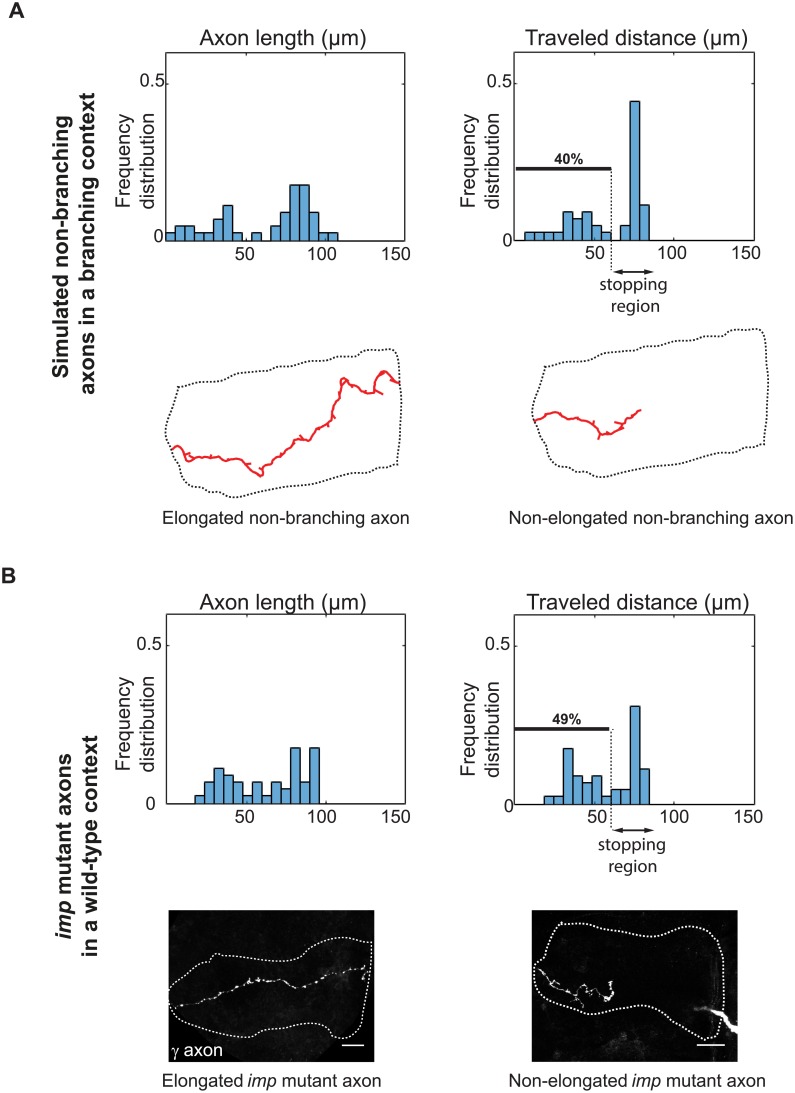
Out-competition of non-branching axons by branching ones.(A) Top: frequency distributions of 2D-projected axon lengths and traveled distances of single simulated non-branching axons grown in the context of otherwise branching axons. 40% of axons fail to reach the lobe extremity in this condition (n = 45). Bottom: examples of fully elongated (left) and growth-defective (right) simulated single axons. (B) Top: frequency distributions of axon lengths and traveled distances of single imp7 mutant axons grown in the context of a wild-type population. A bimodal behavior similar to that generated by simulations is observed (n = 45). Lower panels: example of fully elongated (left) and growth-defective (right) imp7 single axons grown in a wild-type environment and labeled with GFP. Scale bar 10 μm.